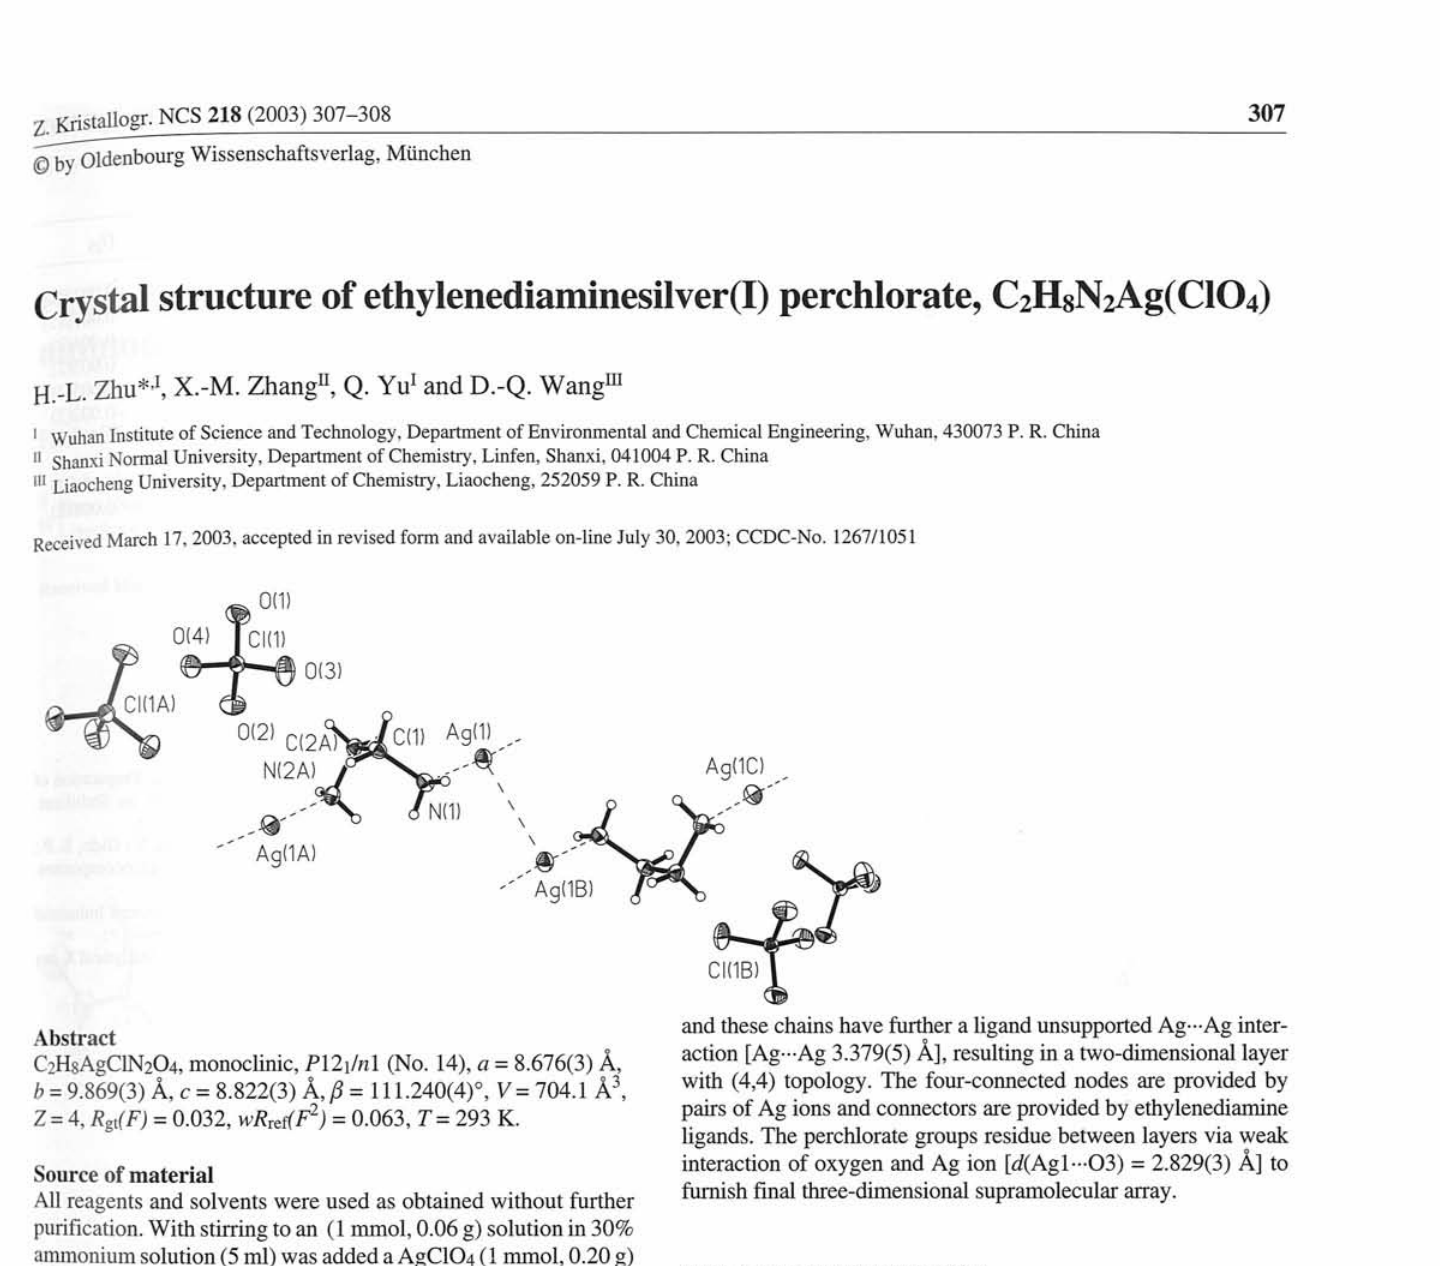
Table 1. Data collection and handling.